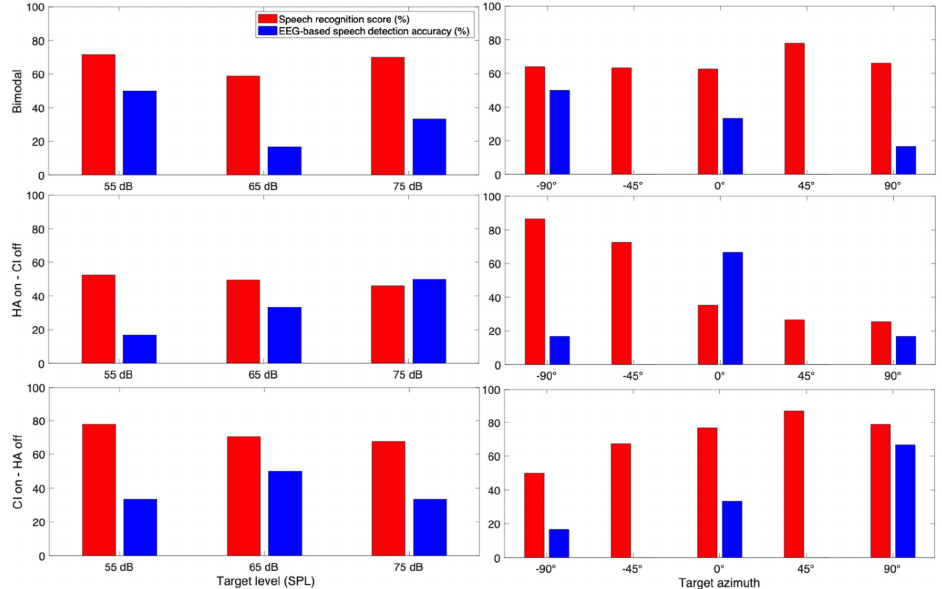
Figure 11. Speech recognition score and speech detection accuracy from EEG for CI 9.